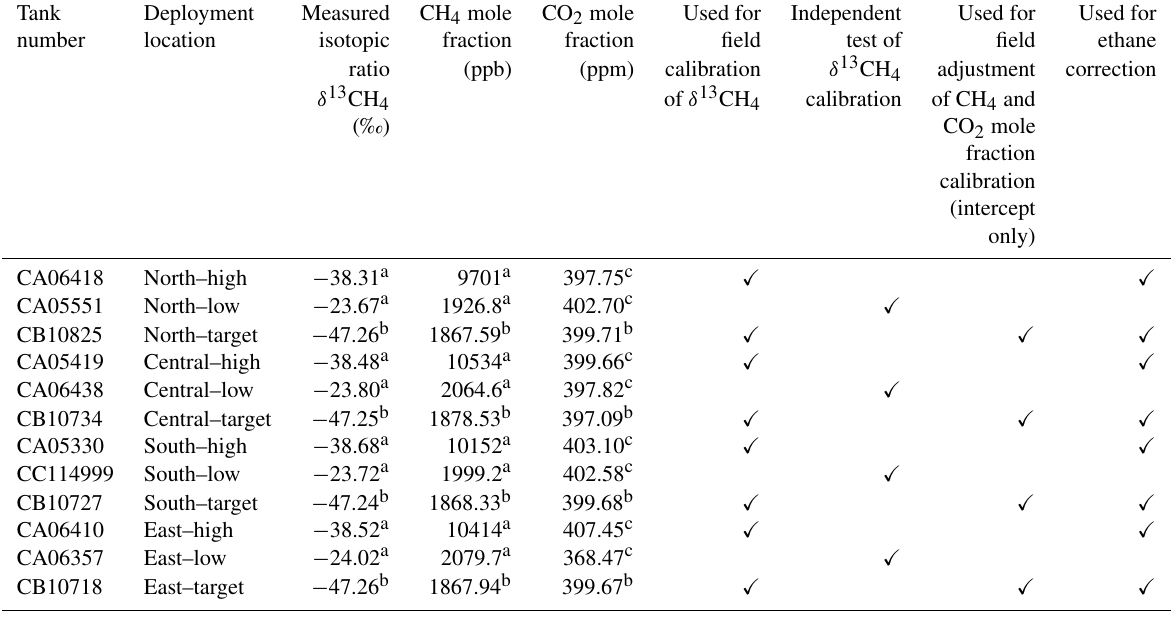
Table 1. Field tanks used at the tower locations. The high and target tanks were used for the field calibration of δ 13 CH 4 . Only the target tank is used for field adjustment of the CH 4 and CO 2 mole fraction calibration. The CH 4 and CO 2 mole fractions for the high and low tanks are less certain than those of the target tanks.